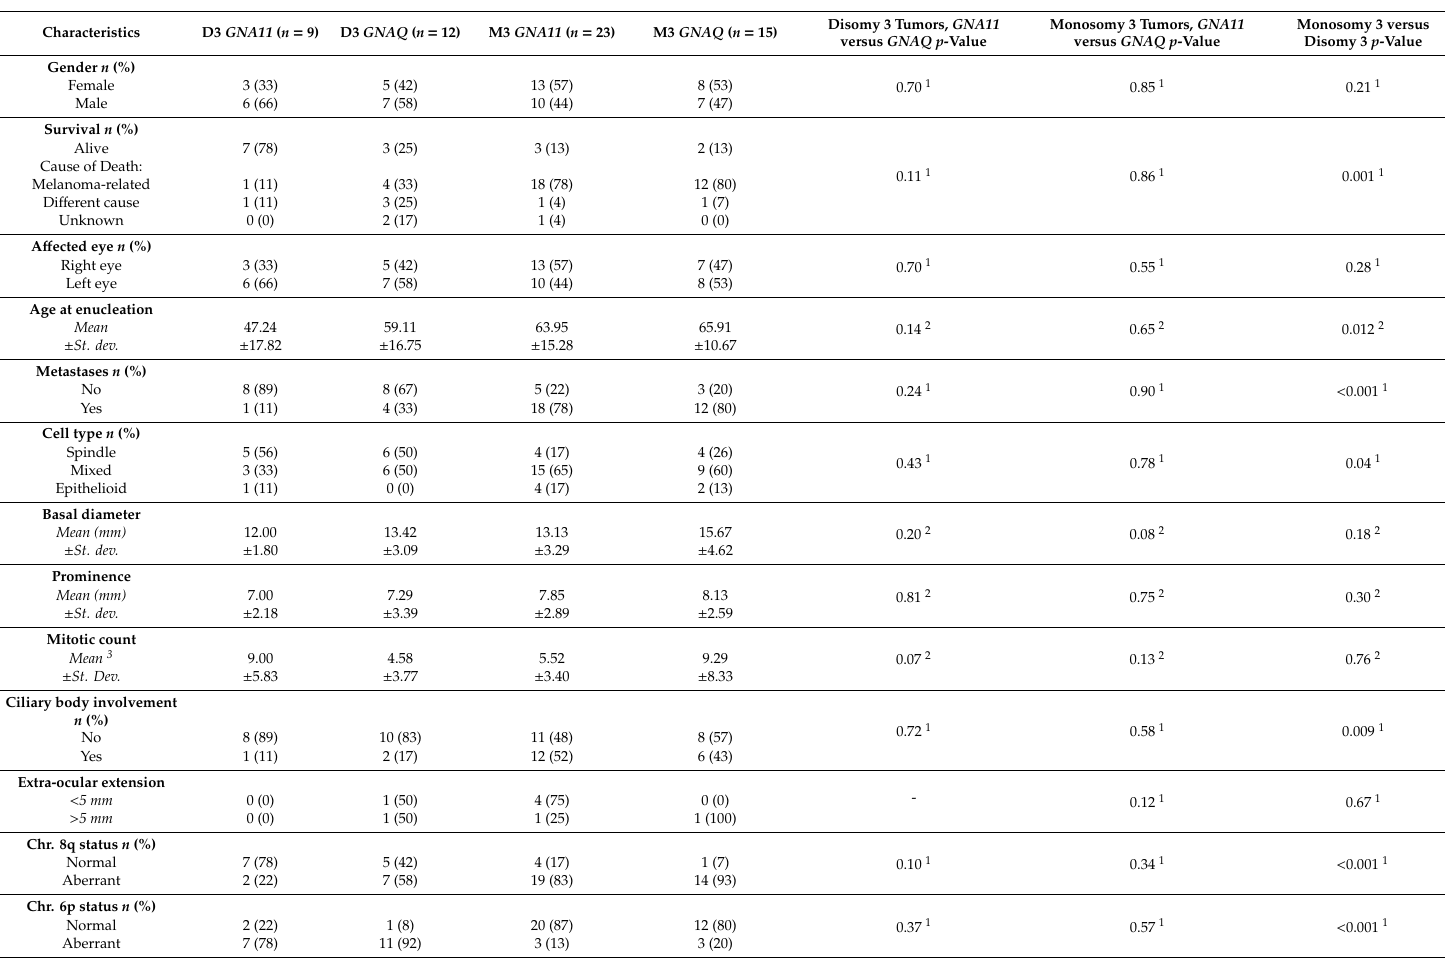
Table 1. Comparison of 59 patients for whom HLA expression (mRNA), chromosome 3 status, and GNAQ / GNA11 status was known. Significantly di ff erent values are represented in bold. The categorical groups were compared using a chi-squared test and numerical data were compared using an independent t